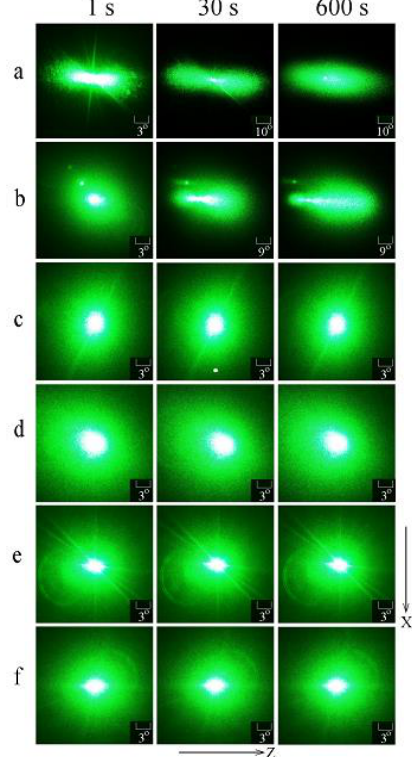
Figure 17. PILS patterns of crystals: ( a ) SLN; ( b ) SLN(K 2 O); ( c ) LiNbO 3 :Zn (4.5 mol.% ZnO); ( d ) LiNbO 3 :Mg:Fe (5.01; 0.005); ( e ) LiNbO 3 :Mg (5.1, solid phase doping); ( f ) LiNbO 3 :Mg (5.3, homogeneous doping). λ = 532 nm. p = 6.29 W/cm 2 . The figure is reproduced with the permission of Pleiades Publishing, Ltd. from the paper Inorg. Mater.: Appl. Res. 2016, V. 7, P. 170 – 176. doi: